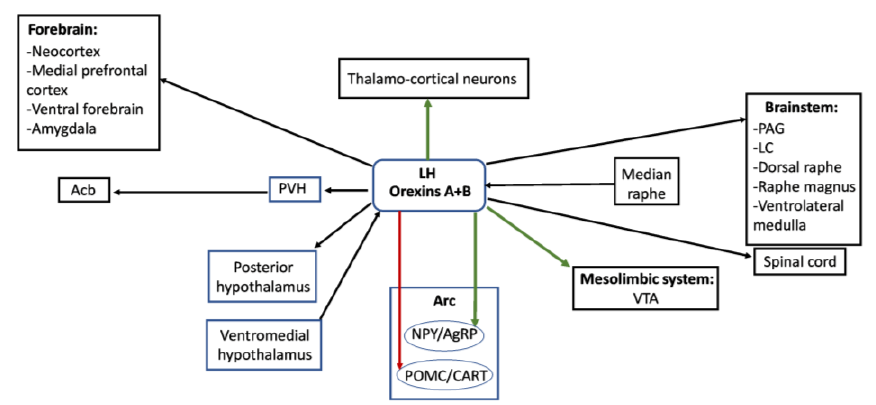
Figure 2. Relationships between different hypothalamic and extrahypothalamic regions involved in the control of feeding. Orexinergic neurons of the lateral hypothalamus send direct projections to other hypothalamic nuclei (posterior hypothalamus), different regions of the brainstem and spinal cord as well as forebrain structures and receive inputs from the median raphe or the ventromedial hypothalamus. Green arrows represent direct activation exerted from the orexinergic neurons to thalamo-cortical neurons, the ventral tegmental area or the NPY/AgRP neurons of the arcuate nucleus, and the red arrow represents the inhibitory projection from orexigenic neurons to POMC/CART neurons of the arcuate nucleus. Abbreviations: Acb—accumbens nucleus; Arc—arcuate hypothalamic nucleus; LC—locus coeruleus; LH—lateral hypothalamus; NPY/AgRP—neurons of the arcuate nucleus containing neuropeptide Y and agouti-related peptide; PAG—periaqueductal gray matter; POMC/CART—neurons of the arcuate nucleus containing pro-opiomelanocortin and cocaine- and amphetamine-regulated transcript; PVH—paraventricular hypothalamic nucleus; VTA—ventral tegmental